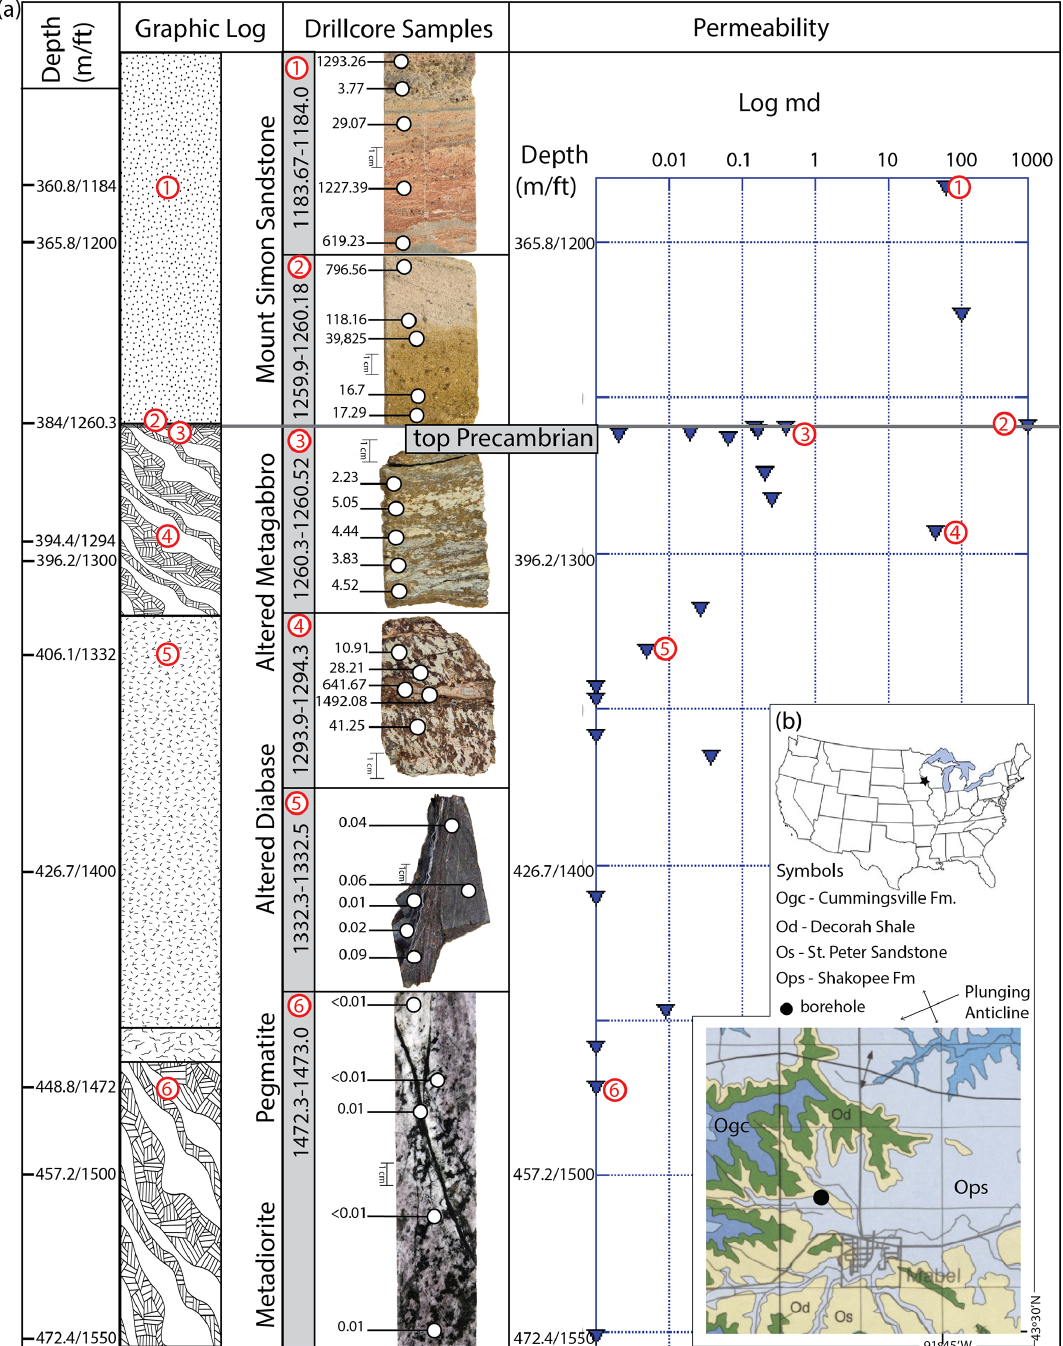
Figure 6. (a) BO-1 lithologic log with select representative core samples of each of the major lithologic units. Above the nonconformity, the analog reservoir, or the injection unit, the Cambrian Mount Simon Sandstone is porous with evidence for both dissolution and oxidation front. The crystalline basement rock consists of foliated, intensely altered, and altered metagabbro with localized faulting, variably altered and faulted diabase localized intrusions, pegmatite dikes, and, at greater depths, relatively unaltered and less-deformed metadiorite. Gas permeability measurements were made on 25 core samples spanning the nonconformity interface. For each core sample tested, five spot measurements were made (locations shown by white circles). For relative comparison across the contact and within the various lithologic units, permeability data (millidarcy, mD) are plotted using a log scale and are the averaged values for each sample. (b) Geologic map modified from Mossler et al.